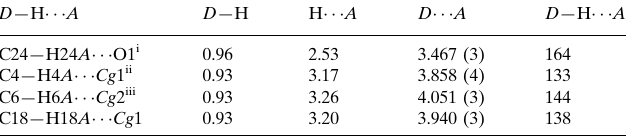
Hydrogen-bond geometry (A˚ , (cid:1)